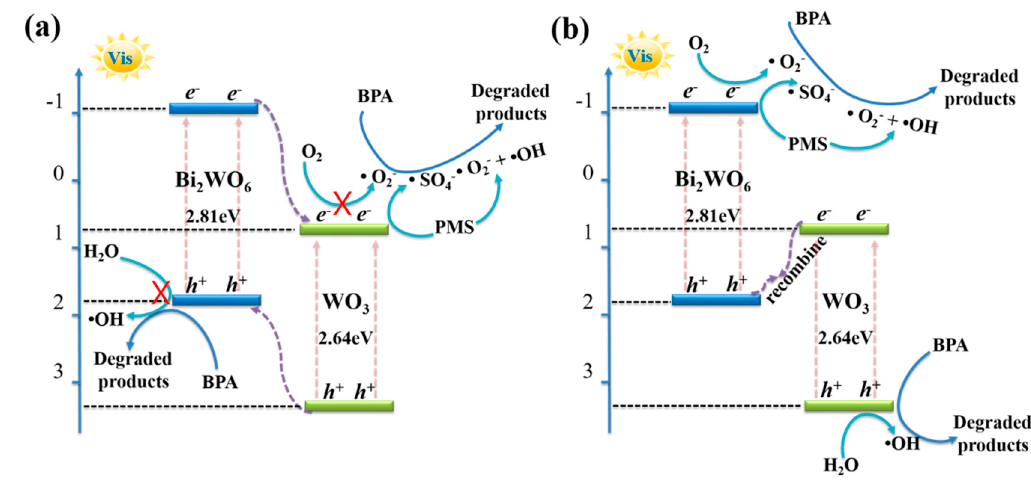
Figure12. TheproposedcatalyticmechanismsofBi 2 WO 6 / WO 3 composite: ( a )thetype-IIheterojunction; Figure 12. The proposed catalytic mechanisms of Bi 2 WO 6 /WO 3 composite: ( a ) the type-II ( b ) the heterojunction; ( b ) the Z-scheme.